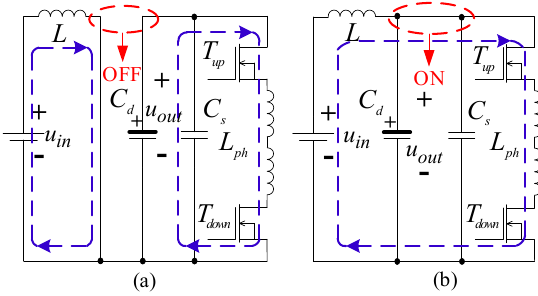
Figure 3. The equivalent circuit of the combination. ( a ) T 9 is on. ( b ) T 9 is off.